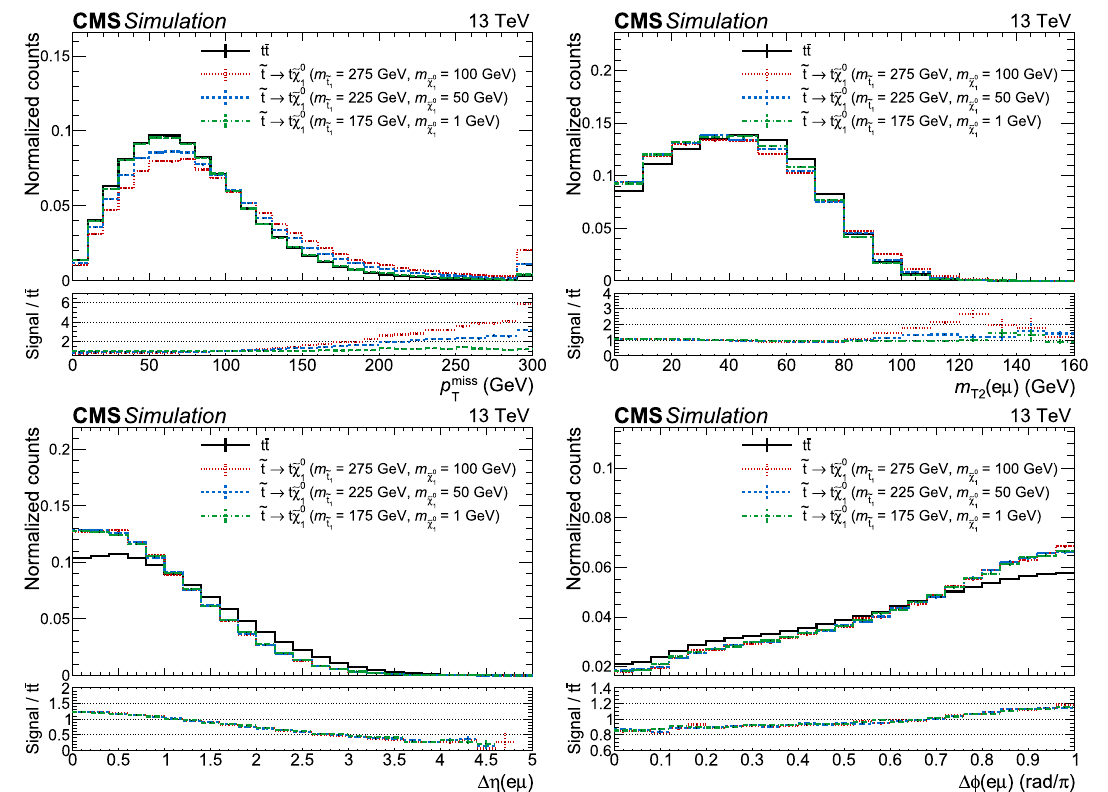
Fig. 4 Normalized distributions for some of the training variables in the baseline selection. Distributions for signal points with different top squark and neutralino masses and SM tt events are compared. From upper left to lower right: p miss T , m T2 ( e μ ) , Δη( e μ ) , and Δφ( e μ )